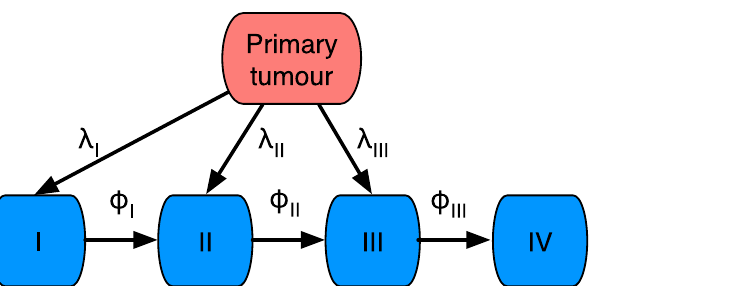
Fig 1. Schematic of the flow of metastatic cells in the case of tongue cancer. The cancer cells flow from the primary tumour to lymph node station I,II and III with rates λ I , λ II and λ III respectively. The flow between lymph node stations is defined by the rates ϕ , ϕ and ϕ I II III